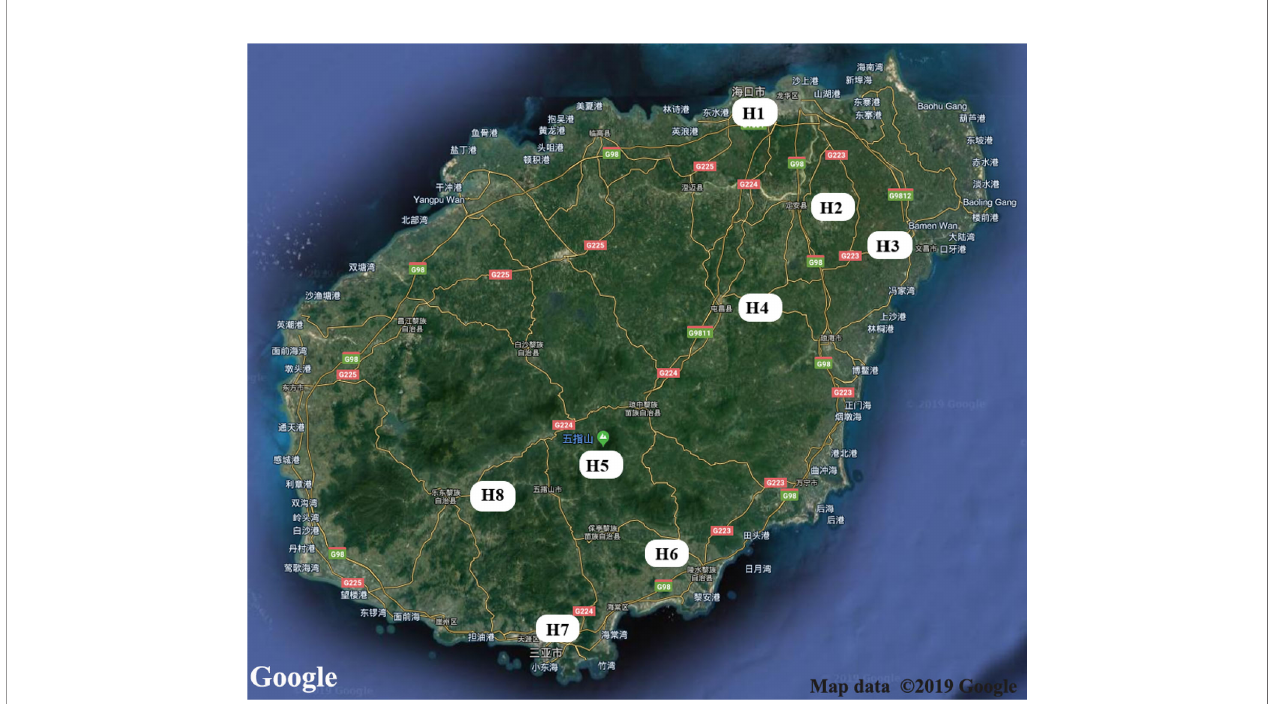
FIGURE 1 | Map of Hainan province showing locations of the eight collection study sites. H1 = Haikou, Urbanna; H2 = Dingan, Country; H3 = Wenchang, Urbanna; H4 = Tunchang, farm; H5 = Wuzhishan, montane; H6 = Lingshui, montane; H7 = Sanya, Urbanna; H8 = Ledong,